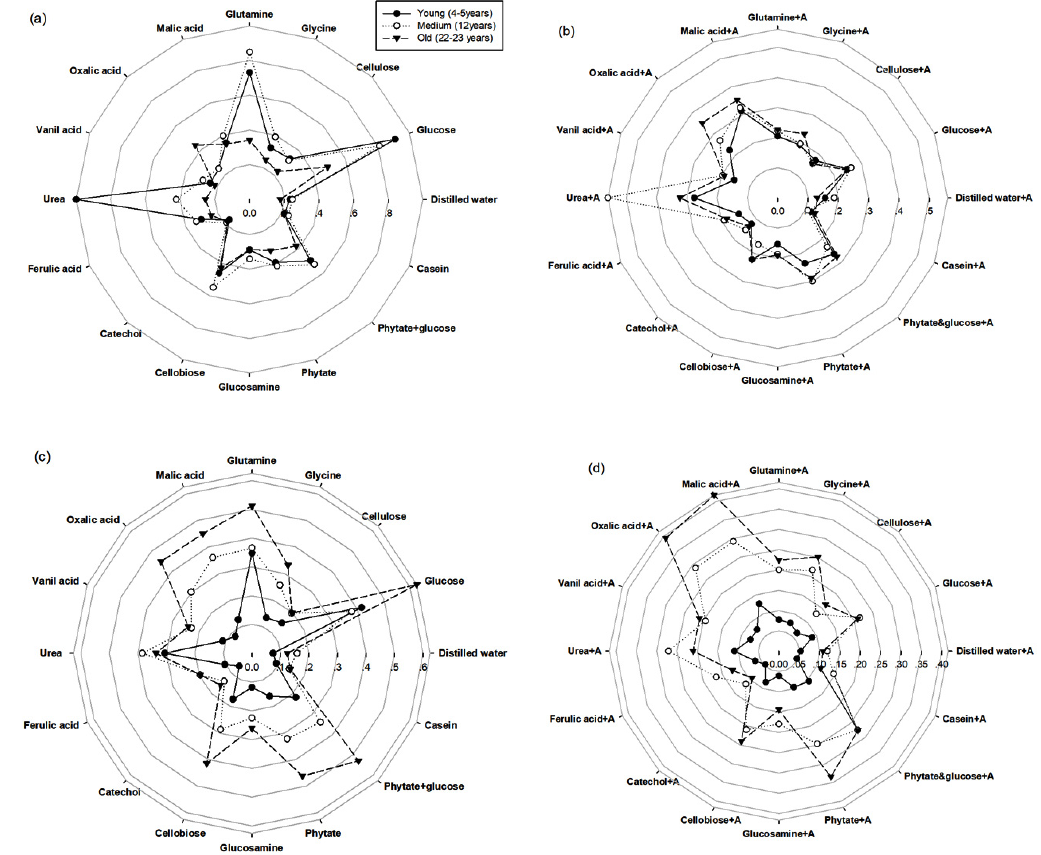
Fig. 1. The relative soil microbial activity from MicroResp-CLPP analysis (substrate induced respiration (SIR): µgC-CO /g/h) under different ages of rubber tree (a) bacteria+fungi in rainy season, (b) fungi in rainy season, (c) 2 bacteria+fungi in dry season and (d) fungi in dry season. The solid line with black circle represents young age of rubber tree (4-5 years), dashed line with hollow circle represents medium age of rubber tree (12 years), and dashed line with black triangle represents old age of rubber tree (22-23